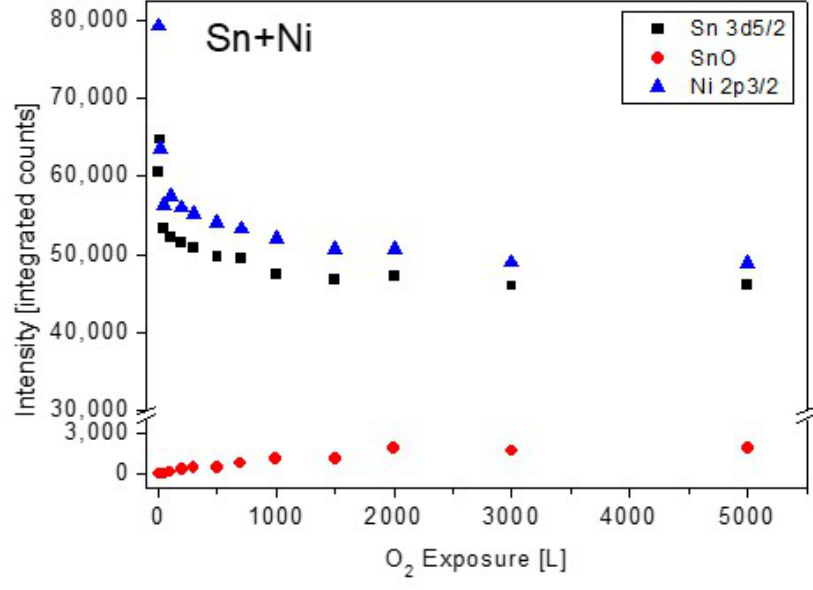
Figure 8. The metallic and oxides intensity of Sn and Ni vs. oxygen exposure at room temperature. Observing the Sn and Ni lines shows that they were attenuated during oxidation. This attenuation implies the possibility that some oxygen-induced segregation of Zr to the surface occurs, and screens the Sn and Ni signals, as it is clearly seen at higher temperatures oxidation. The ZrO 2 thickness formed at RT, which is shown in Figure 9, was estimated from the attenuation of the Zr, Ni and Sn peaks, using Equation (1). The IMFP of the Ni 2p 3 / 2 , Sn 3d 5 / 2 and Zr 3d 5 / 2 electrons passing through the ZrO 2 film were evaluated as λ Ni ≈ 1.4 nm, λ Sn ≈ 2 nm [19] and λ Zr ≈ 2.2 nm [25]. It can be seen that the oxide thickness obtained from the attenuation of Ni and Sn is similar (0.7 nm), while the oxide from the Zr line is much thicker (1.6 nm). These differences can point to the mechanism of the oxide formation. Since the Zr attenuation is influenced by the total thickness of the formed oxide, it